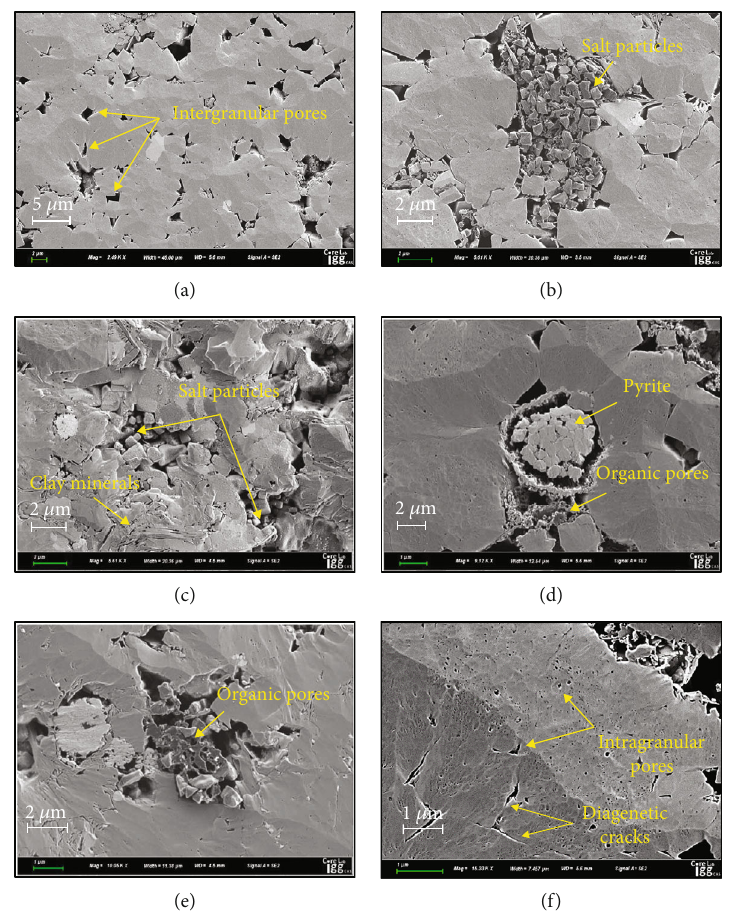
Figure 3: Original pore structure characteristics of intersalt dolomitic